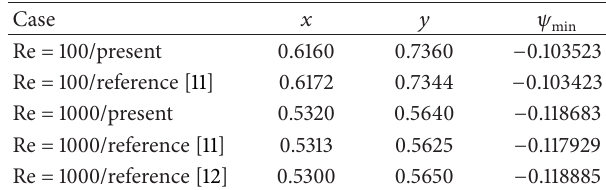
Table 1: Comparison on minimum stream function value of primary vortex and position of vortex center.